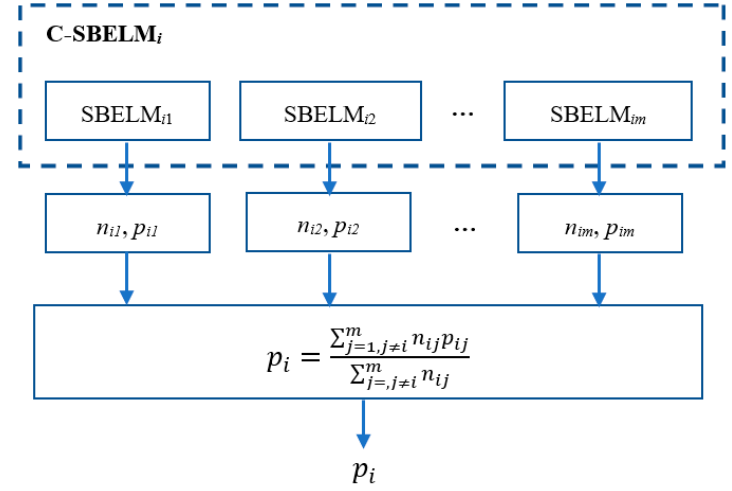
Figure 3. The procedure of probability output fusion.